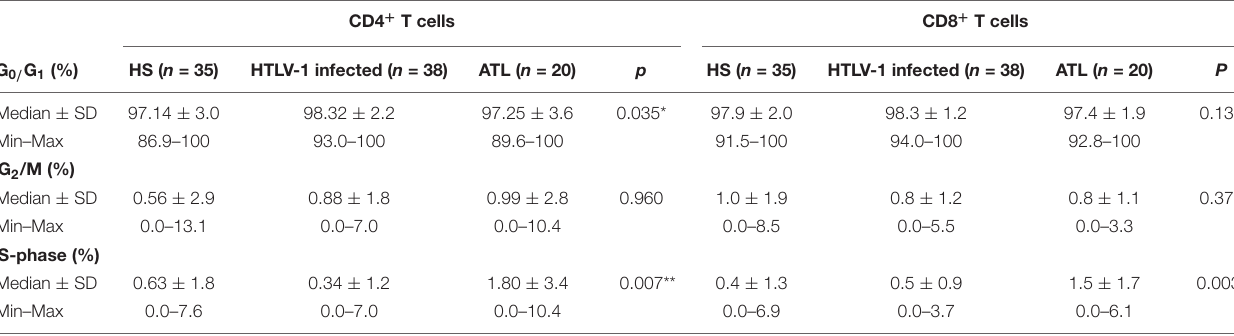
TABLE 2 | Tlymhocytes cell cycle.